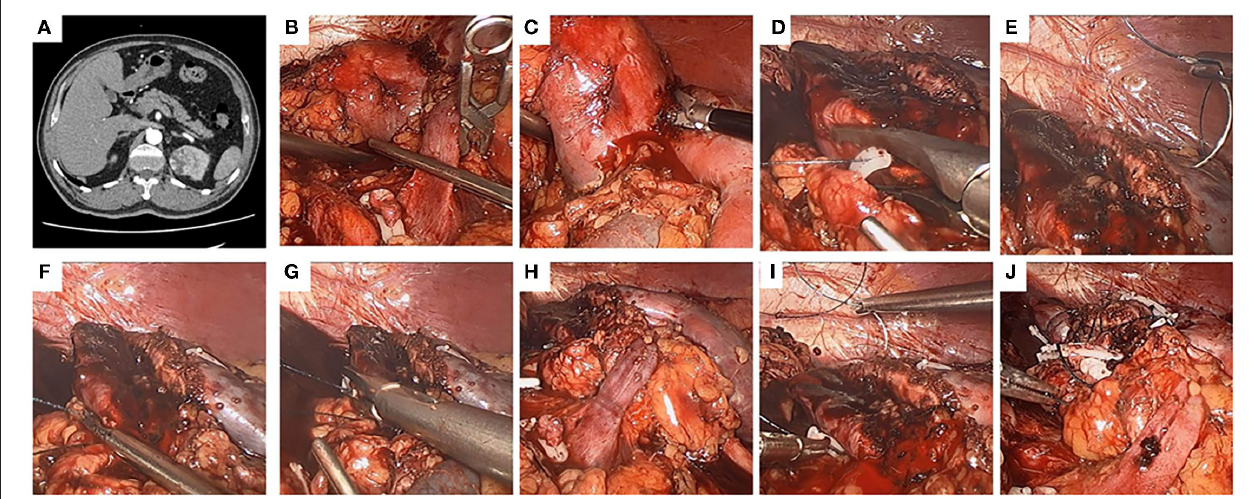
FIGURE 2 | The use of the modified two-layer suture in a left kidney. A left-kidney, 4.1-cm-diameter, mesophytic tumor striding both anterior and posterior sides, and the modified two-layer suture technique was performed. (A) Crosssection of computed tomography (CT) scan. (B) The renal artery was clamped. (C) The tumor was removed by a scissors. (D) The inner layer was closed by continuous suture, and the tail of the suture was secured by a Hem-o-Lok. (E,F) The modified two-layer suture was used to close the outer layer, the first suture began at the central point of the outer layer. (G) Both the inserting and removing points of the first suture were secured by Hem-o-Lok clips, so that the two sides of the outer layer were attached closely to each other. (H) The clamp was removed to restore kidney perfusion. (I) The sutures were continuously run from one end to the other end in the outer layer. (J) The kidney wound was closed.